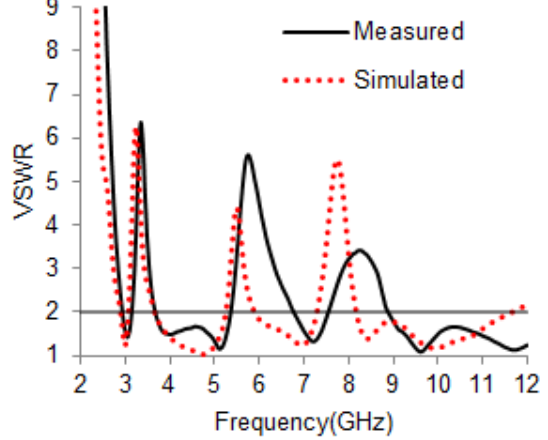
Figure 7: (b) VSWR curve for variation in length of slot-B for proposed Antenna-D.